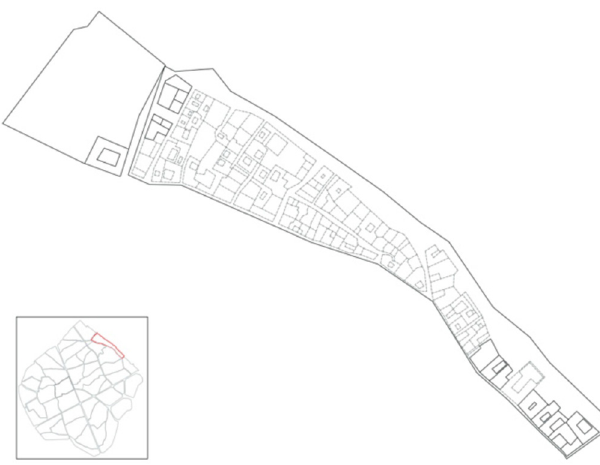
Fig. 12. Al Maidan riverfront area. Only the buildings in bold colour are the ones that are still standing